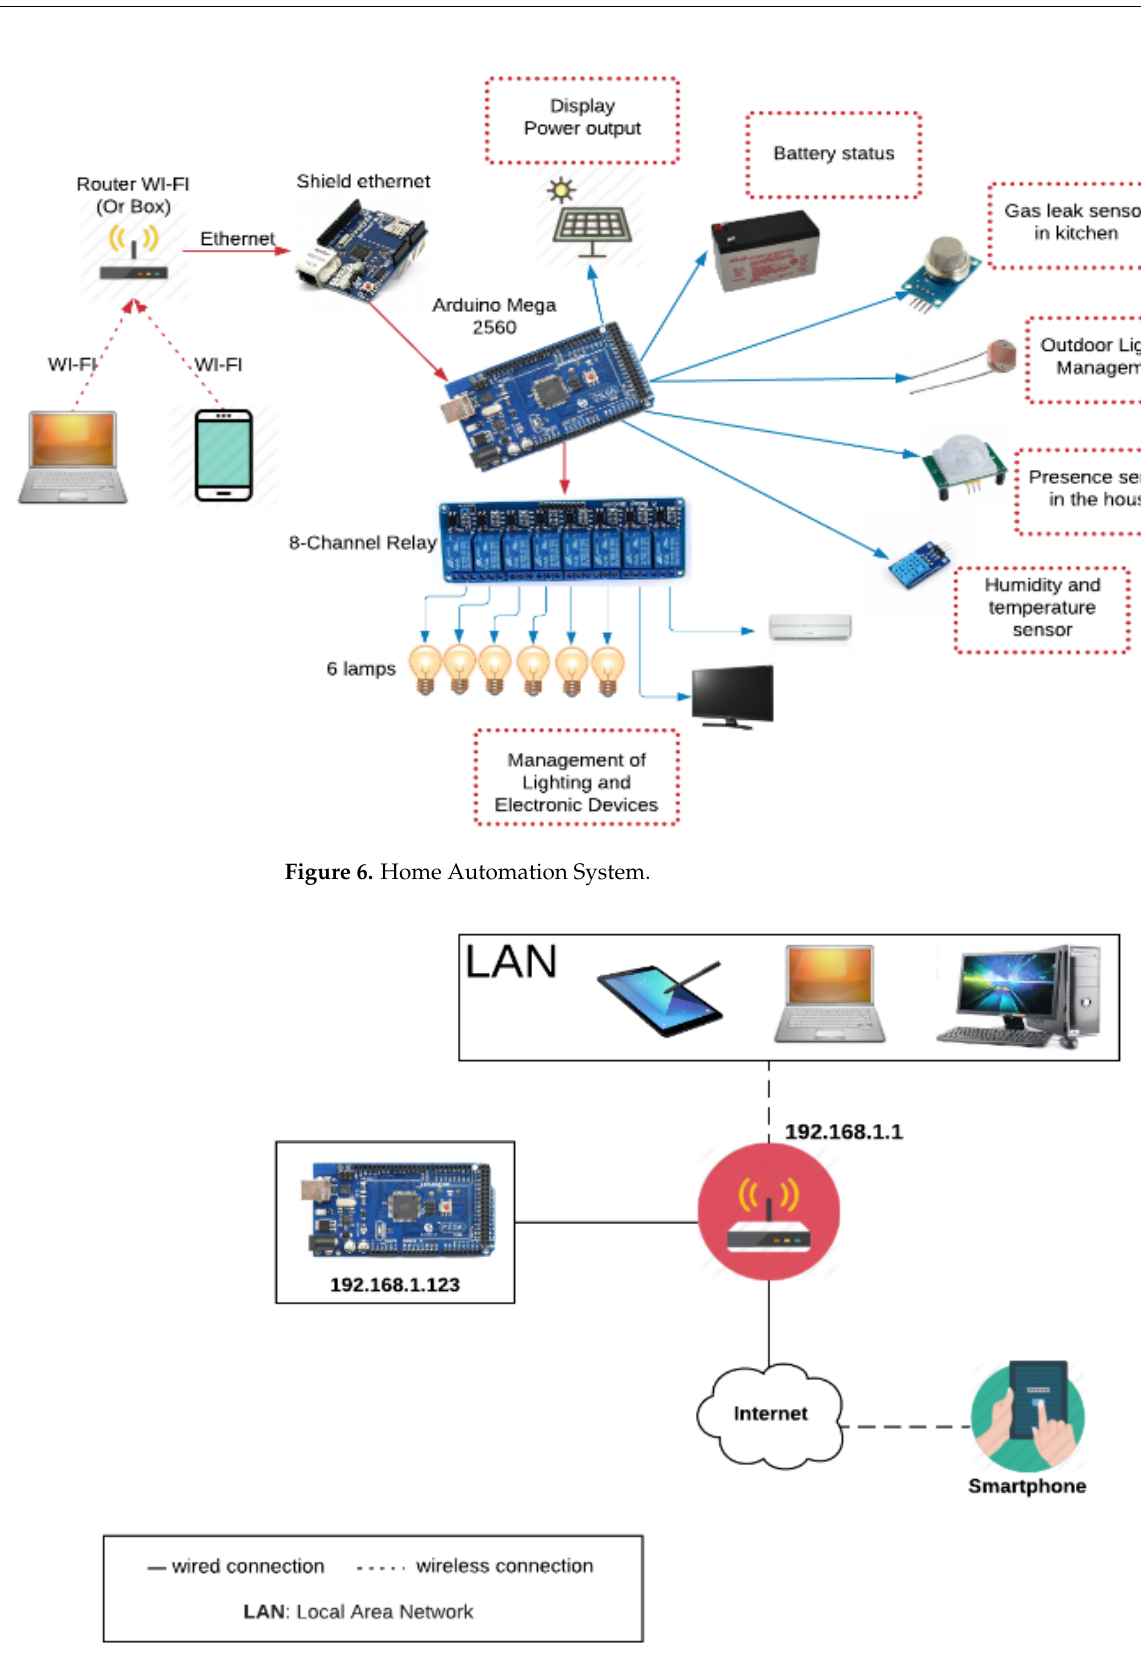
Figure 7. Description of Network architecture.